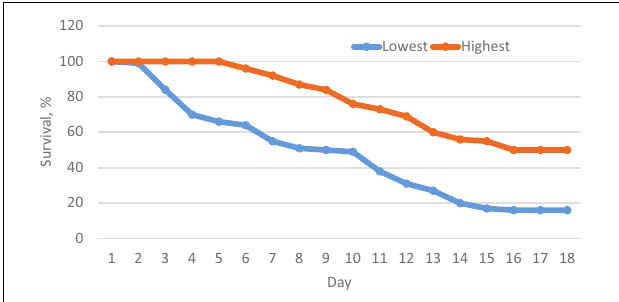
FIGURE 1 | Survival trend over 15 days period after the challenge test in the highest and lowest resistance families.